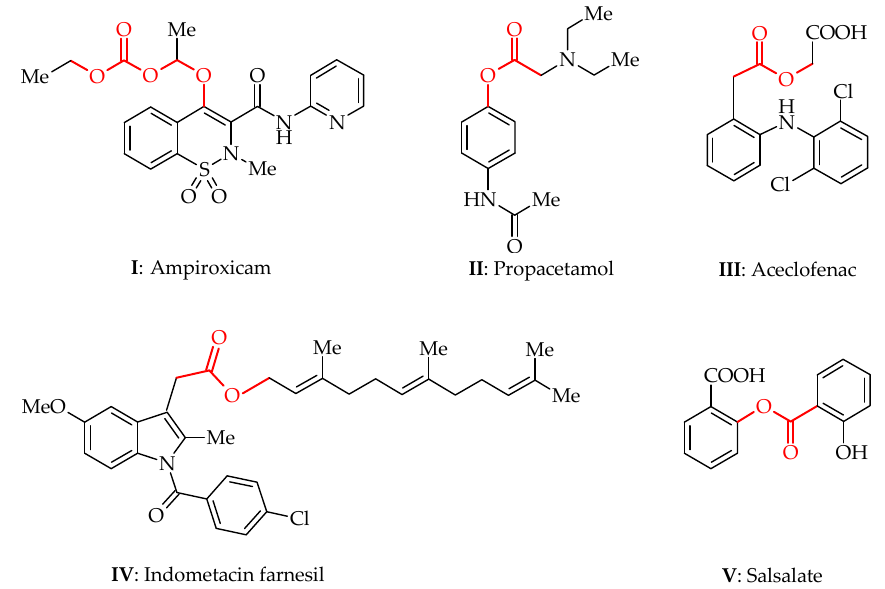
Figure 1. The ester-prodrugs of analgesic acids and phenols that are officially registered drugs [1,2].